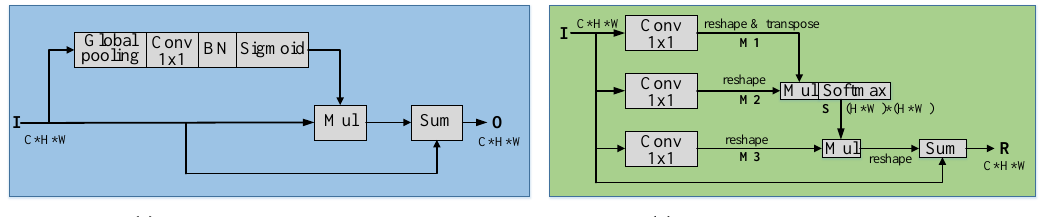
Figure 6. The attention